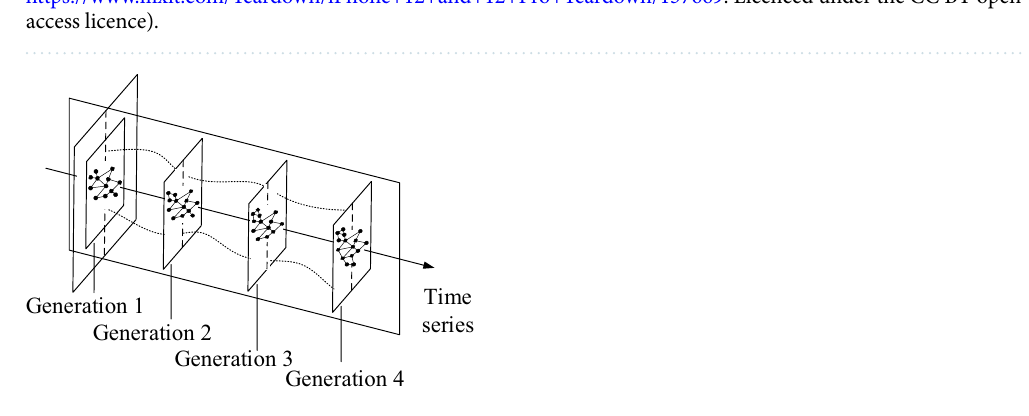
Figure 3. Illustration of product structural networks for product